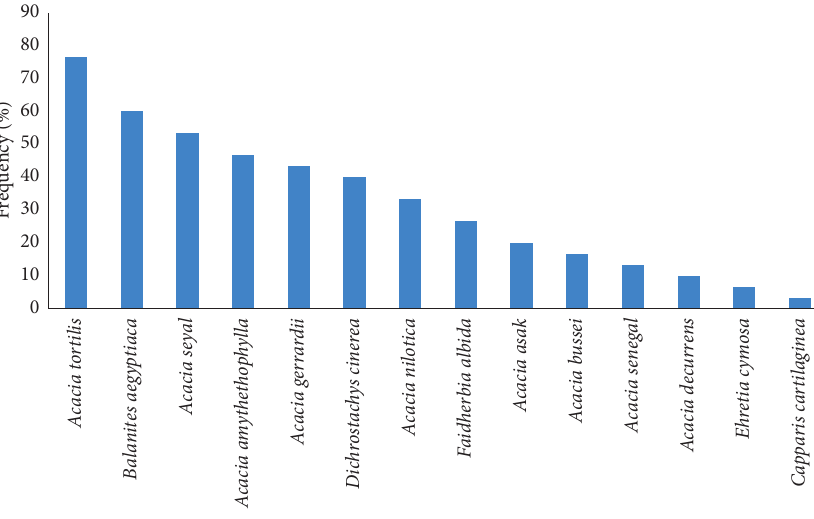
Figure 4: Frequency of occurrences of woody species in free grazed woodland. Table 4: Summary of IVI of woody species in free grazed woodland in descending order. Free grazed